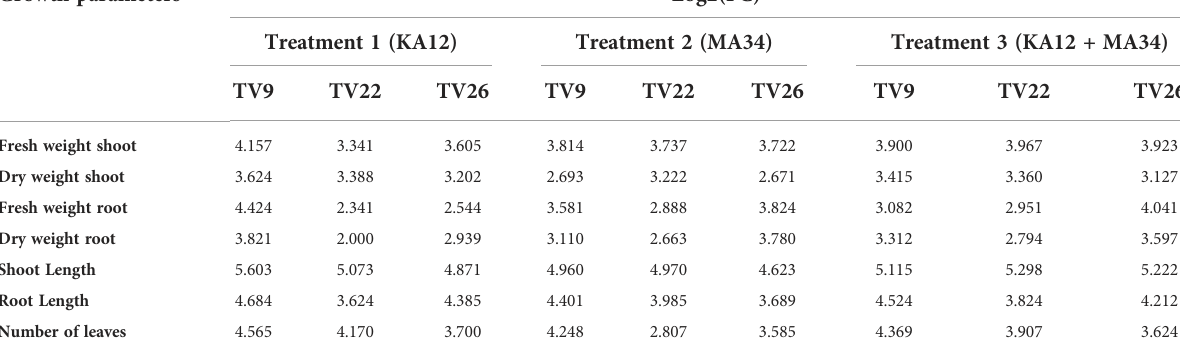
TABLE 5 Fold change analysis of tea clones TV9, TV22 and TV26 treated with actinobacterial strains. Growth